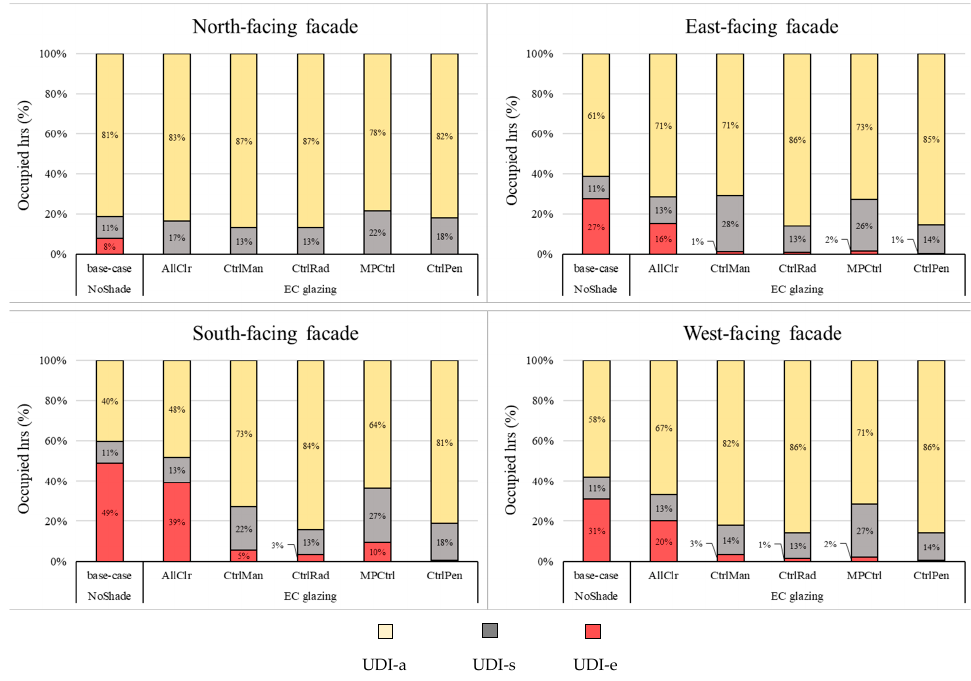
Figure 9. The overall performance of the EC glazing system in terms of daylight availability for different orientations results for occupants closer to the façade (G1). The UDI-a corresponds to the percentage of the occupied hours when the preferred daylight is provided. Therefore, the case with maximum UDI-a shows the best performance of a control strategy for providing daylight sufficiency and avoiding the risk of glare. In relation to the base-case window (see Table 1 base-case, T vis = 0.58), the results show applying an EC glazing protects the occupants in group G1 from “too bright” daylighting, while it causes “too dark” cases for the occupants in group G2 deeper inside the room. For group G1 (closer to the window), the UDI-a for the base-case window was 81%, 61%, 40%, and 58% for the north-, east-, south-, and west-facing windows, respectively. By applying the EC glazing with the optimal control, the UDI-a was improved to 85%, 81%, and 86% for the east-, south-, and west-facing windows, respectively. For the north- facing window, the UDI-a was about 81% for both cases. By using more advanced control strategies (from manual operation to optimal control), the full potential of an automated system for providing useful daylight can be achieved. It is worth mentioning that this performance could be different for a different shading system, particularly for a non-coplanar device (e.g., Venetian blind), which can redirect daylight into deeper space. 4.4. Thermal Comfort Even though the air temperature stays in the acceptable range (here 20 °C to 27 °C), thermal comfort -especially for the occupants close to the façade- needs to be evaluated. Fanger’s Predicted Mean Vote (PMV) method has been widely used for the estimation of thermal sensation and comfort in the built environment [56]. Local PMV was internally calculated in TRNSYS for each occupant position. The calculation involves room temperature, relative humidity, and local mean radiant temperature (MRT). Other